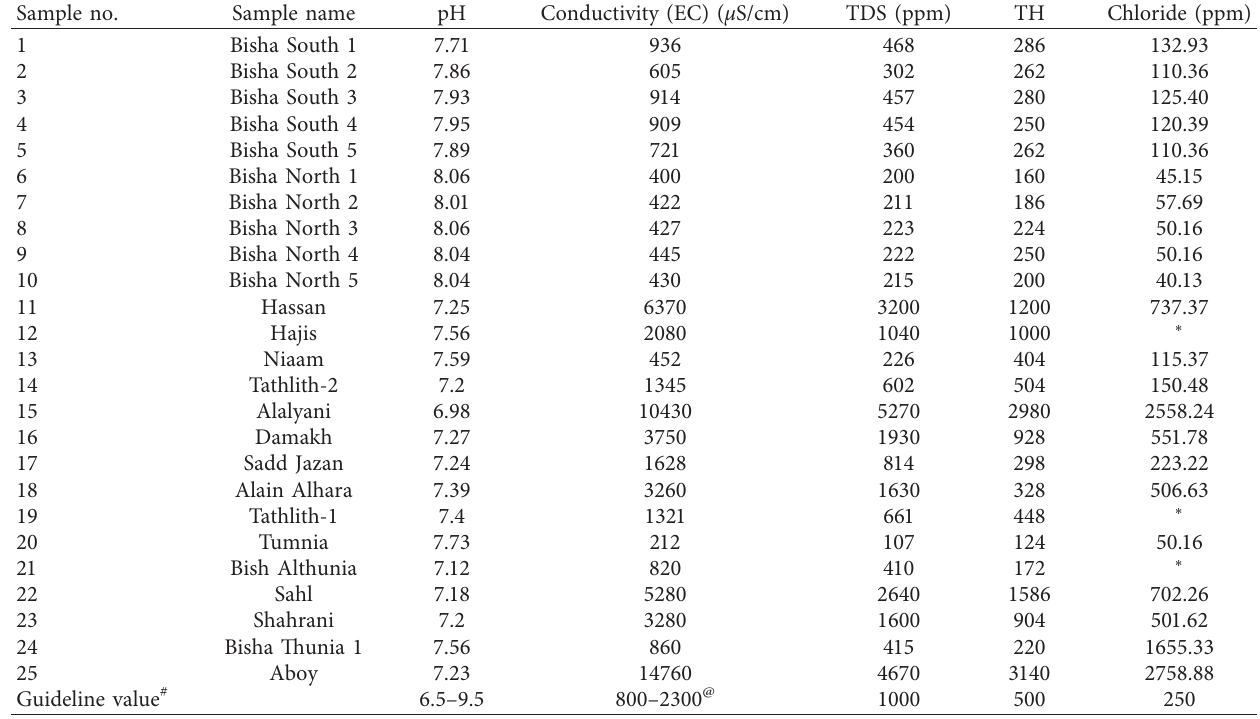
Table 1: Conductivity, TDS, pH, TH, and chloride concentration for 25 groundwater samples. Sample no.